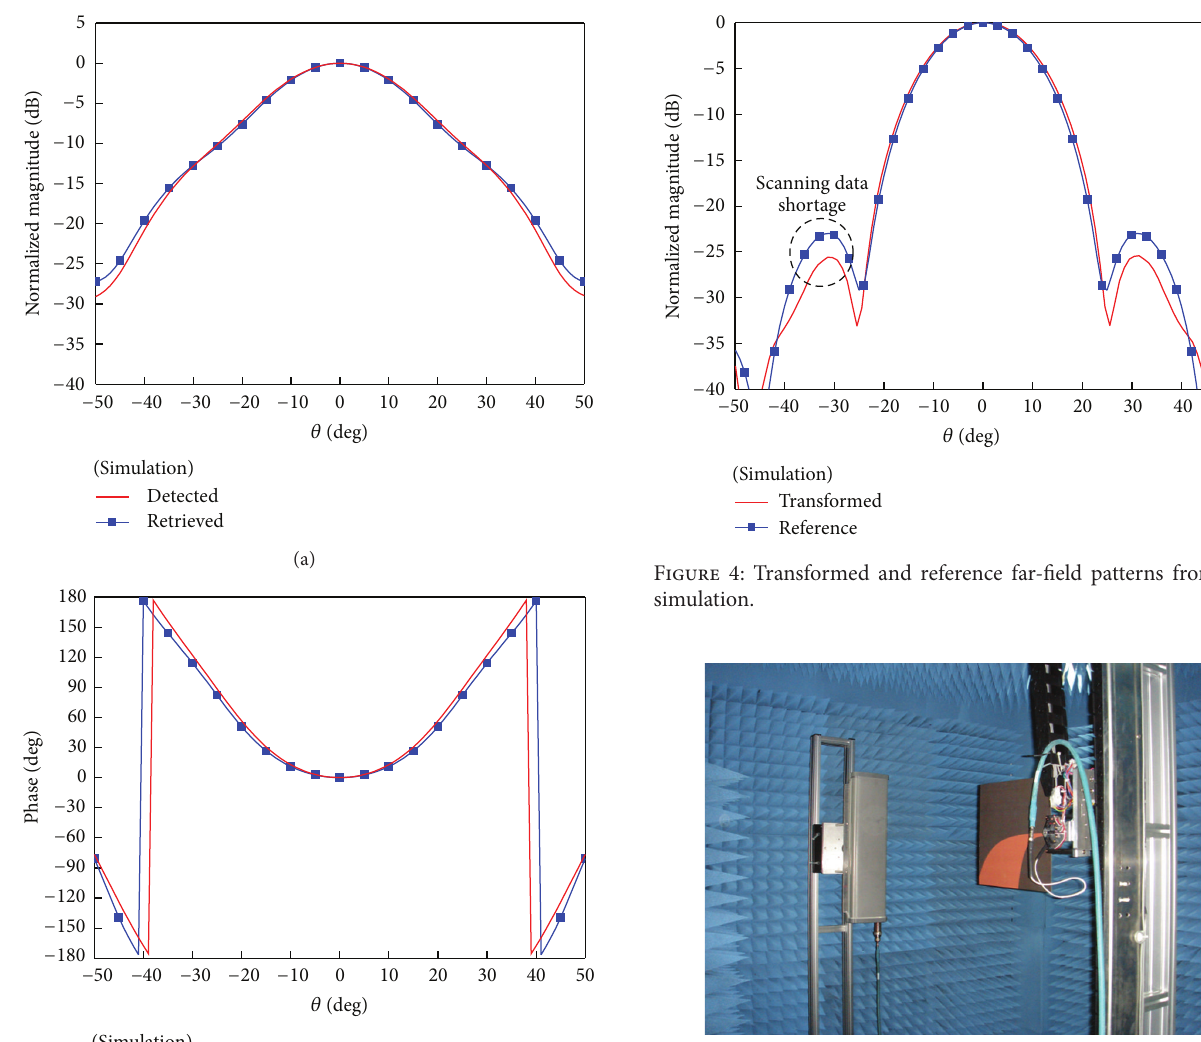
Figure 5: Photograph of experiment of the base-station antenna in a small anechoic